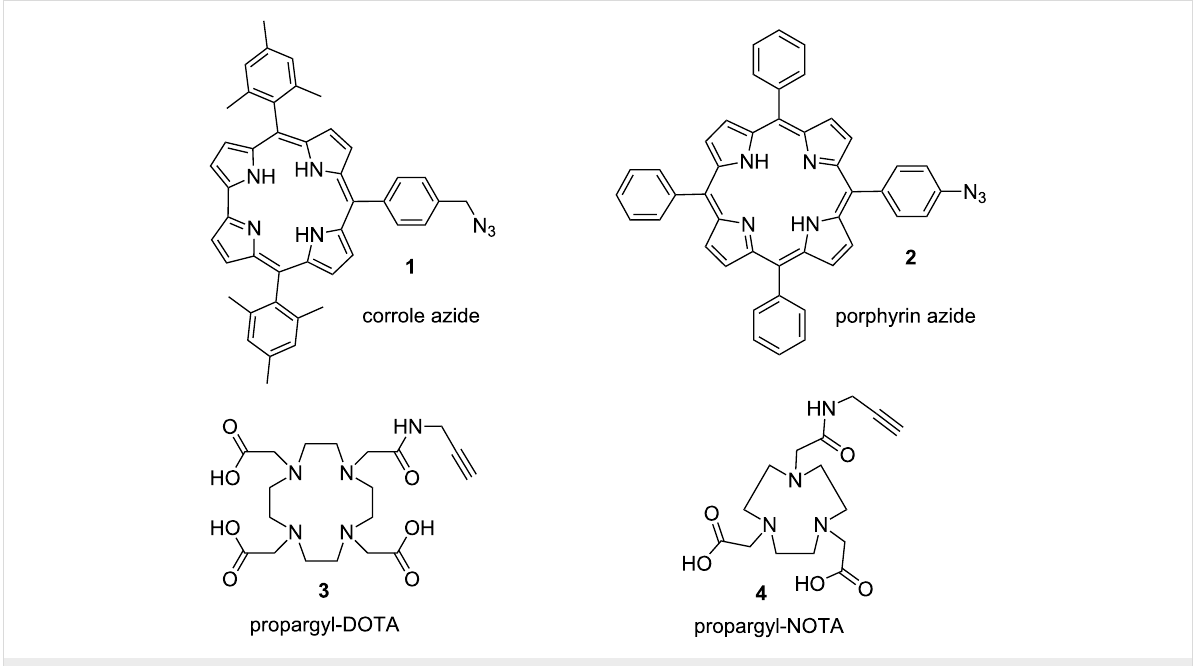
Figure 1: Selected ligands for the copper(I)-catalyzed Huisgen